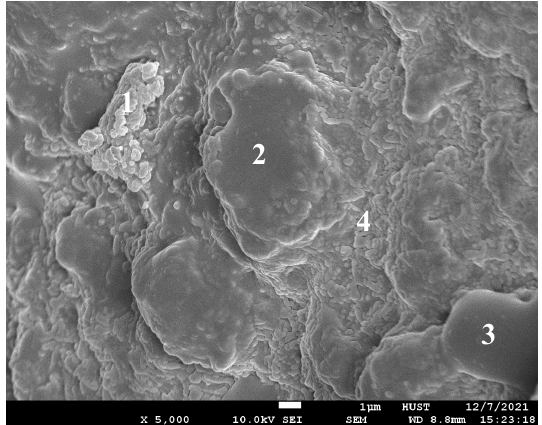
Figure 13. SEM image of the center of the coating after ablation. 1,2,3,4 represent different position points. Table 6. EDS results of the center of the coating after ablation. Element (at.%)